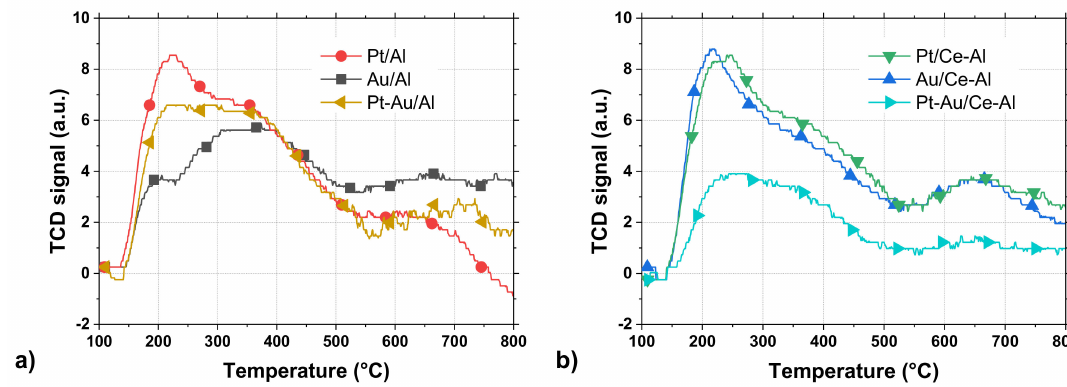
Figure 3. Temperature-programmed desorption of ammonia (NH 3 -TPD) profiles of the Pt, Au, and Pt-Au catalysts supported on ( a ) Al 2 O 3 and on ( b ) CeO 2 -Al 2 O 3 , (TCD = thermal conductivity detector).